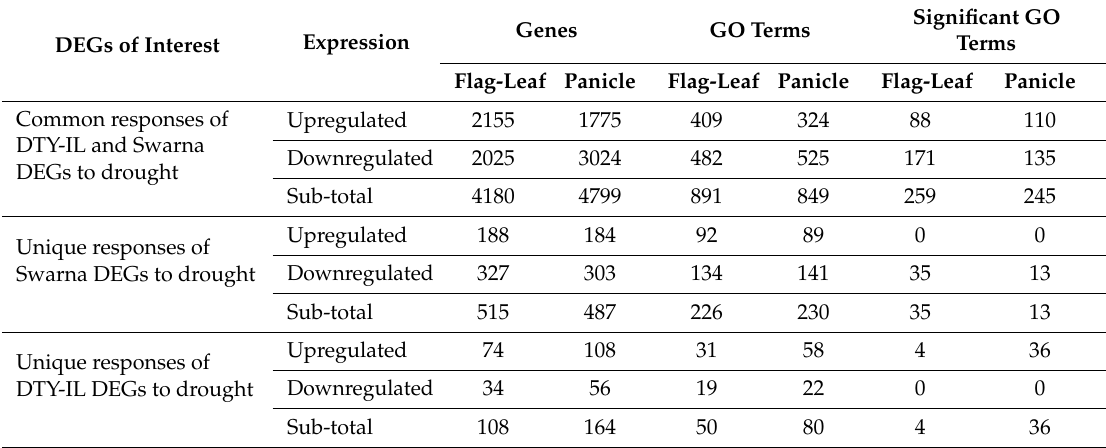
Table 1. A summary of GO enrichment analysis of di ff erentially expressed genes (DEGs) common to both genotypes, and unique to DTY-IL and Swarna for flag-leaf and panicle tissues under